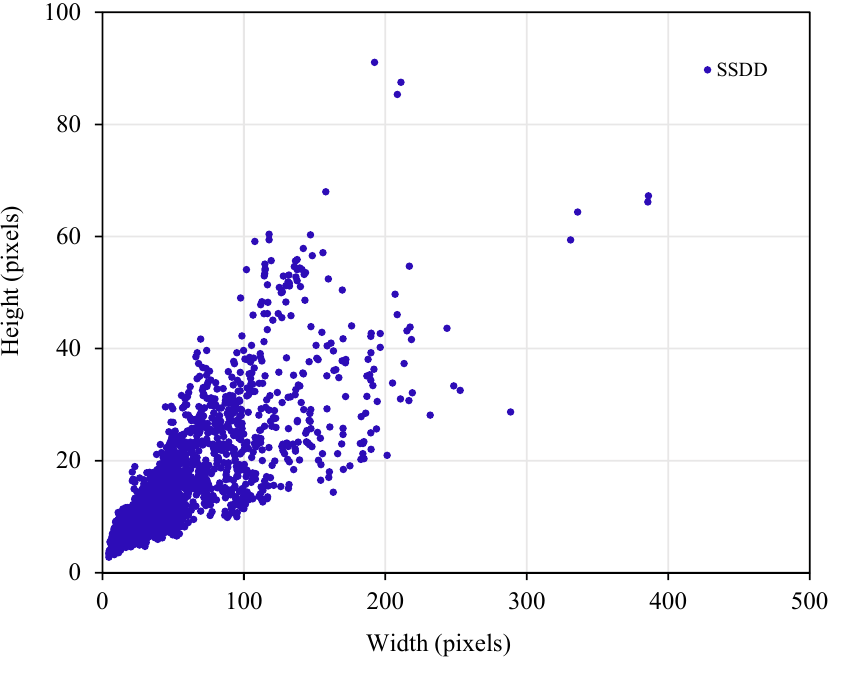
Figure 1. Distribution of ship size on SSDD. Table 2. Statistical results of multiscale ships in SSDD.